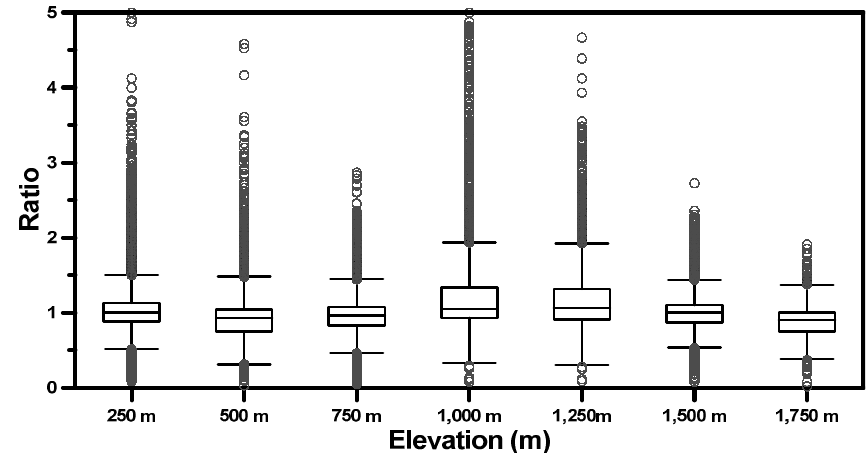
Figure 9. Box plots of radar reflectivity ratio between two adjacent cells derived at each altitude zone.